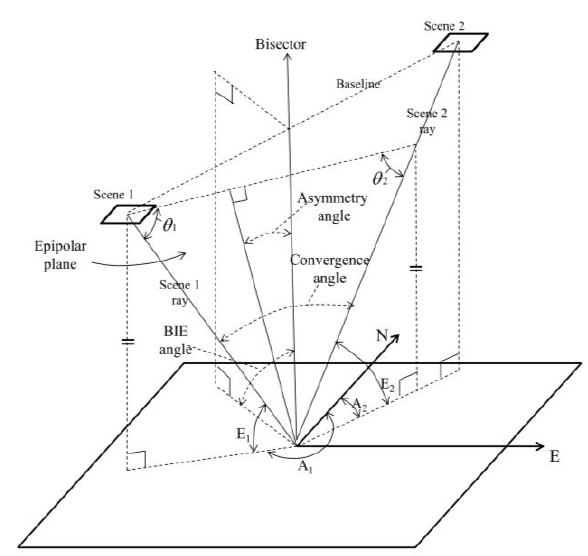
Figure 1. Representation of the satellite stereo geometry showing the convergence, bisector elevation, and asymmetry angles (Jeong and Kim, 2016).